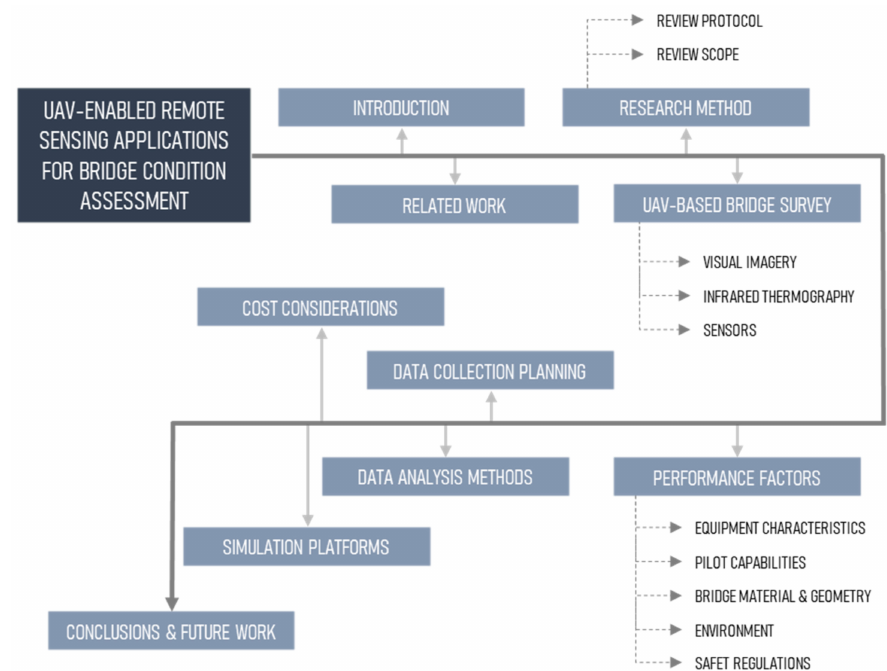
Figure 1. Structure of the article depicting the main elements of the